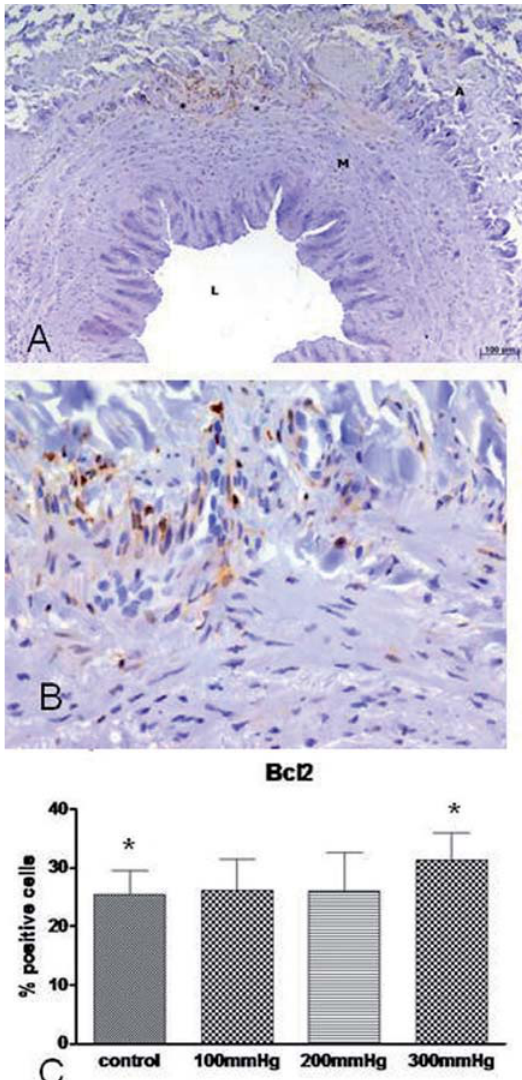
Fig. 4 - Representative photomicrographs of immunohistochemical analysis for expression of Bcl-2 in segments of vein submitted for fifteen seconds at 300 mmHg (A): original magnification 100X; (B): original magnification 400X. Adventitial layer (A), lumen (L) and muscular layer (M). An asterisk (*) indicates places with the highest positive mark. (C) The numbers (mean, SD) of the Bcl-2 positive cells of approximately 600 cells in control and segments of the vein submitted for fifteen seconds at 100, 200 and 300